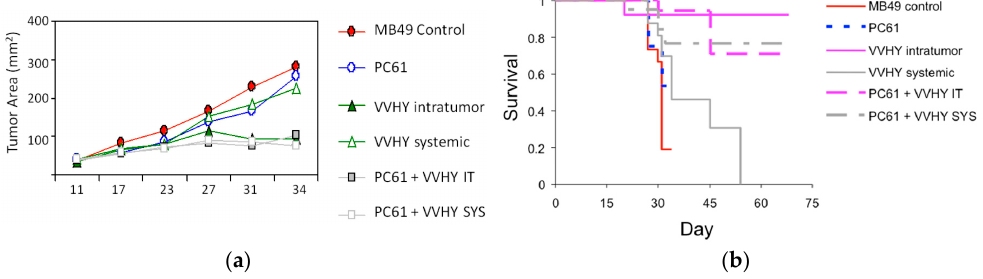
Figure 2. Neutralization of Tregs enhances the tumor growth-inhibiting effects of both systemic and intratumoral TAA vaccination. Combination treatment with the anti-CD25 monoclonal antibody PC61 and either systemic or intratumoral VV-HY (a cocktail of two rVVs encoding genes coding for two immunodominant tumor antigens) inhibits tumor growth ( a ) and results in prolonged survival ( b ) compared to treatment with either systemic or intratumoral VV-HY alone. Reprinted from [91], with permission from Elsevier.